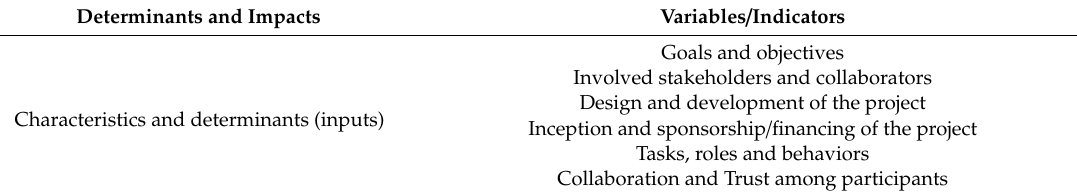
Table 1. Variables / indicators for the